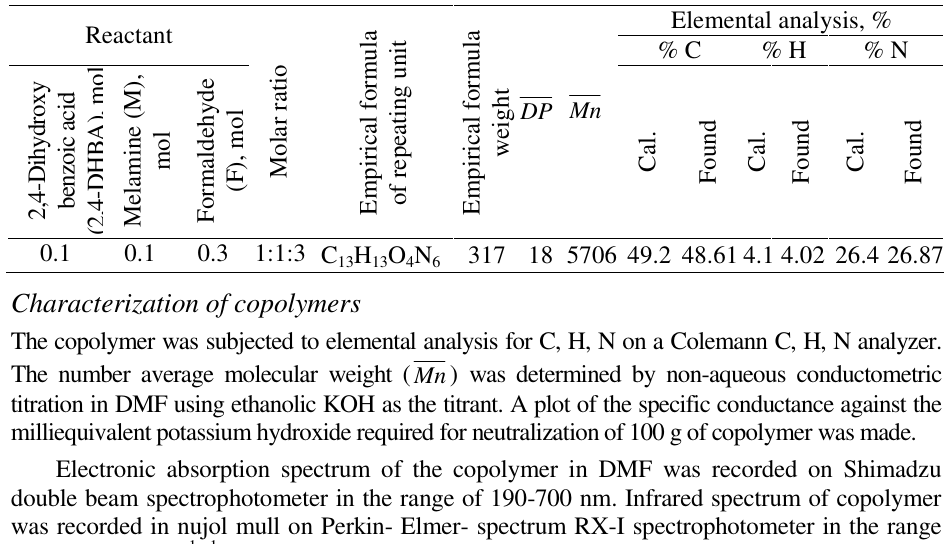
Table 1. Synthesis and physical data of 2,4-DHBAMF copolymer resin.